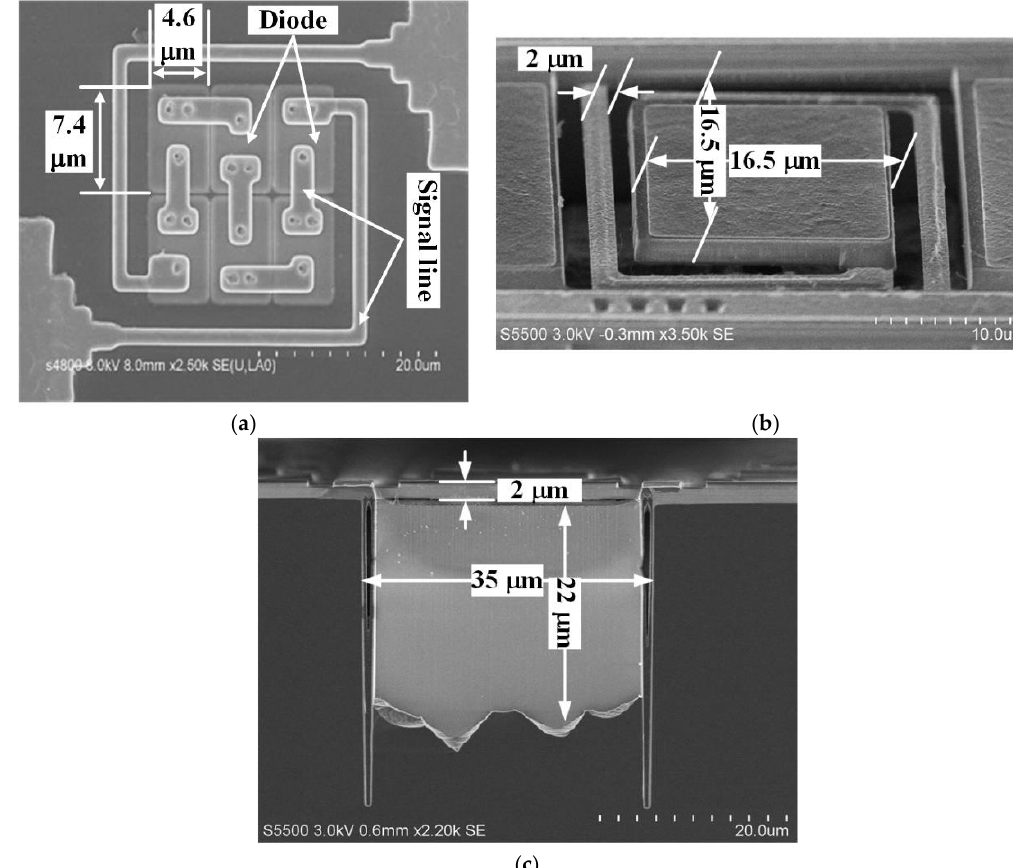
Figure 9. ( a ) SEM image of six series diodes. ( b ) Top and ( c ) cross-sectional views of the fabricated micro-Pirani vacuum sensor.